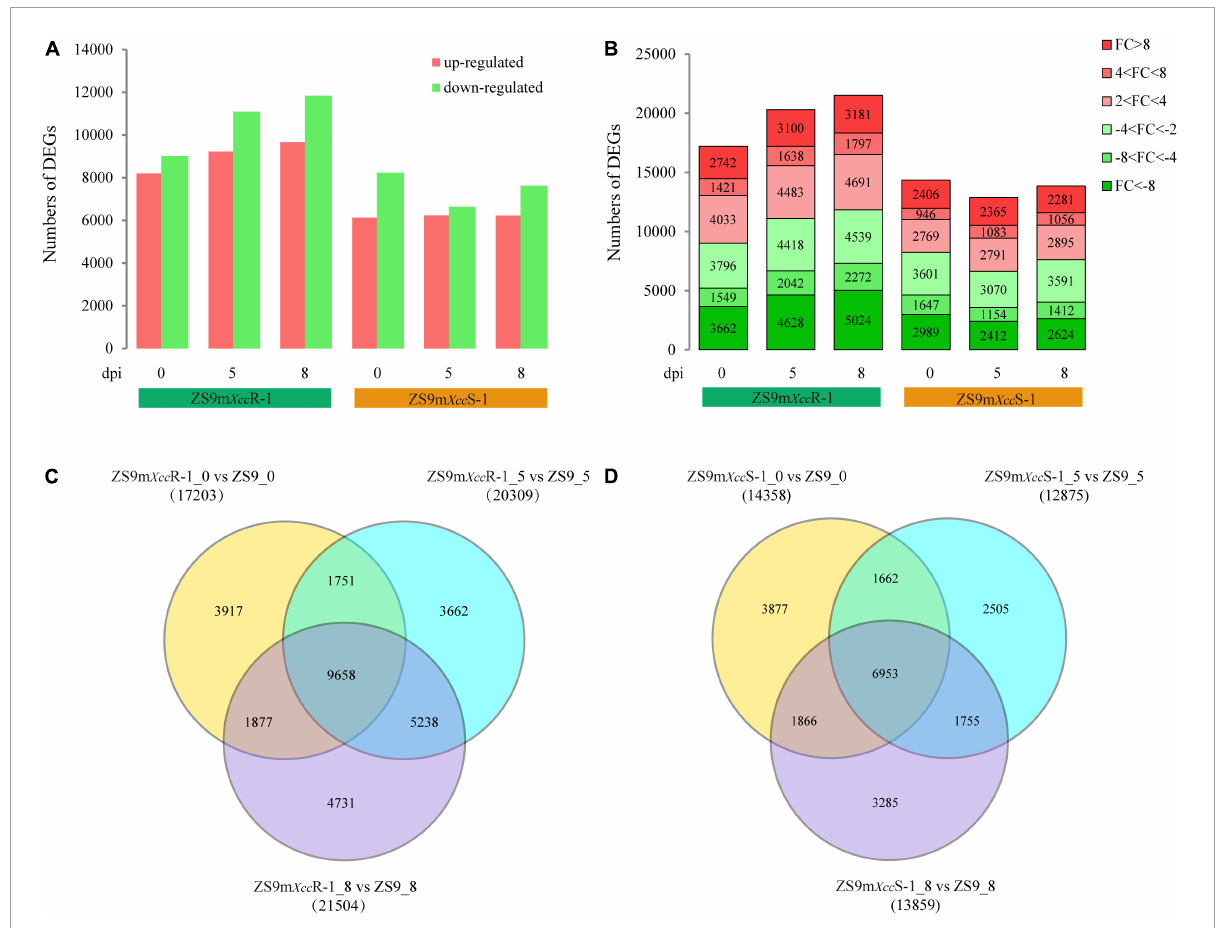
FIGURE3 Comparative analysis of differentially expressed genes between B. napus ZS9 and the two EMS-lines ZS9m Xcc R-1 and ZS9m Xcc S-1 at different time points post inoculation. (A) Numbers of up-regulated and down-regulated DEGs in ZS9m Xcc R-1 and ZS9m Xcc S-1 at 0, 5, and 8 dpi. (B) Fold change (FC) distribution of DEGs in ZS9m Xcc R-1 and ZS9m Xcc S-1 at 0, 5, and 8 dpi. FC was calculated as the ratio of gene read counts between ZS9m Xcc R-1/ZS9m Xcc S-1 and ZS9. Venn diagrams displaying numbers of common and unique DEGs in the resistant ZS9m Xcc R-1 (C) and the susceptible ZS9m Xcc S-1 (D) at three time points post inoculation,